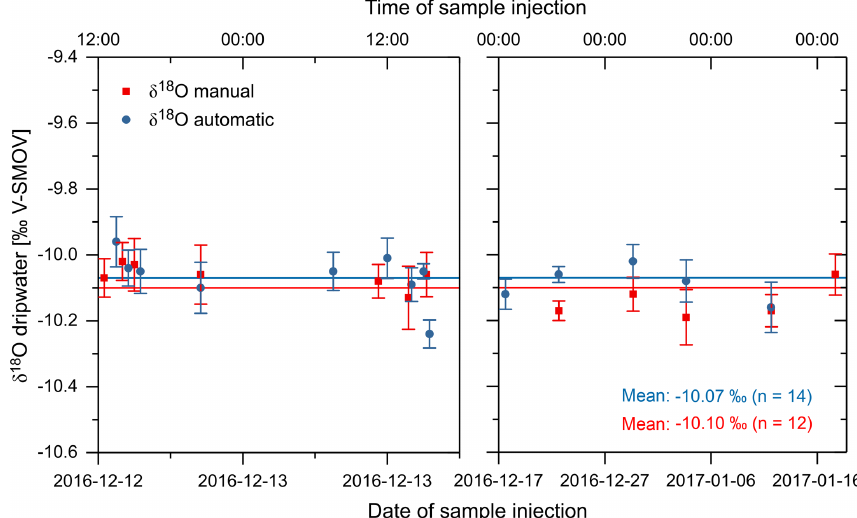
Figure 5. First field testing of the GUARD autosampler: oxygen isotope values (indicated as δ 18 O relative to the V-SMOW international standard) in dripwater samples from a specific drip site in the “Laichinger Tiefenhöhle” karst cave in the Swabian Alb region, southern Germany. Samples were collected automatically (blue circles) over the course of 33 days (13 December 2016 to 14 January 2017) and supplemented by 12 samples collected manually (red squares) for comparison of both methods. Error bars represent measurement uncertainty. Blue and red horizontal lines indicate the overall arithmetic mean of each data set. Note the difference in scale of the x axes of the two sub- plots. Not all of the 33 samples were analysed for isotopic composition.